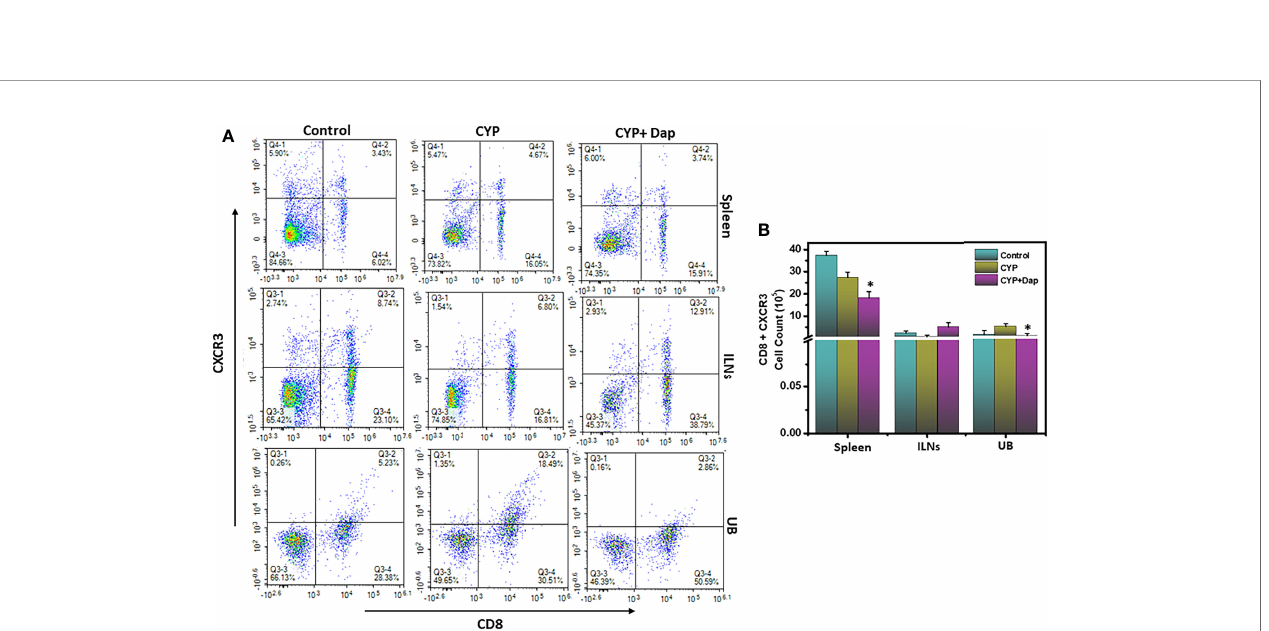
FIGURE 3 | Dap treatment reduces the systemic and UB CXCR3+ T cells. Single-cell suspensions from spleen, ILN, and UB were isolated from the three groups as in the legend in Figure 2 and stained for T cell activation markers using anti-CXCR3 Abs. (A) shows a representative experiment indicating the percentages of CD8+CXCR3+ cells (A, upper right quadrant). (B) shows Mean values ± SEM from three independent experiments involving six mice per group (n=18) are shown.Asterisks indicate statistically signi fi cant differences between CYP+vehicle and CYP+Dap treatment groups (*p <